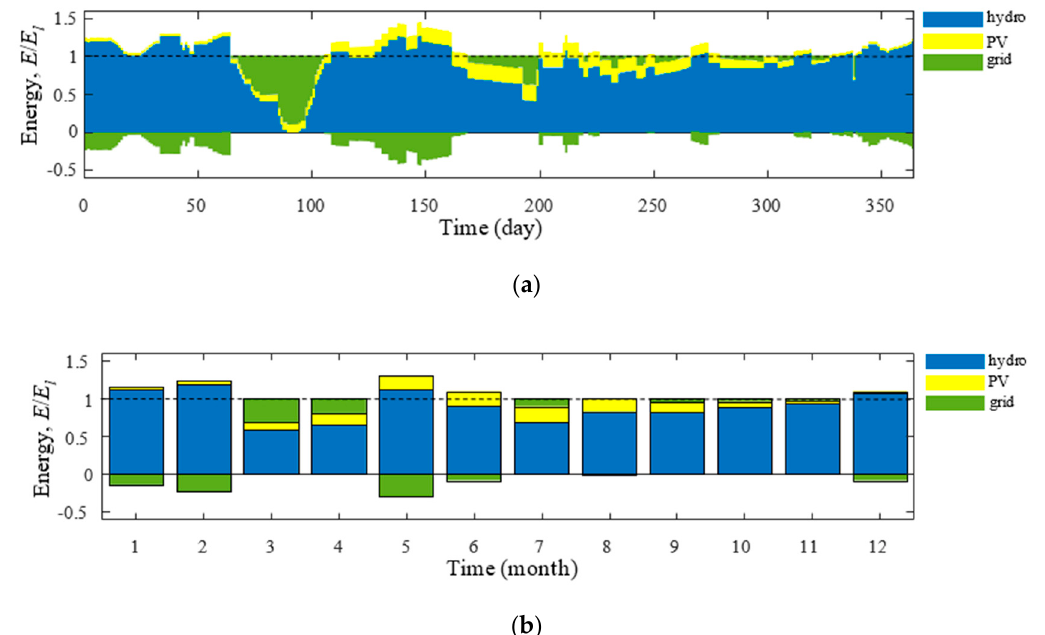
Figure 18. Energy balance of the hybrid hydro/PV battery system: ( a ) one-day averaging and ( b ) one-month averaging related to load energy.